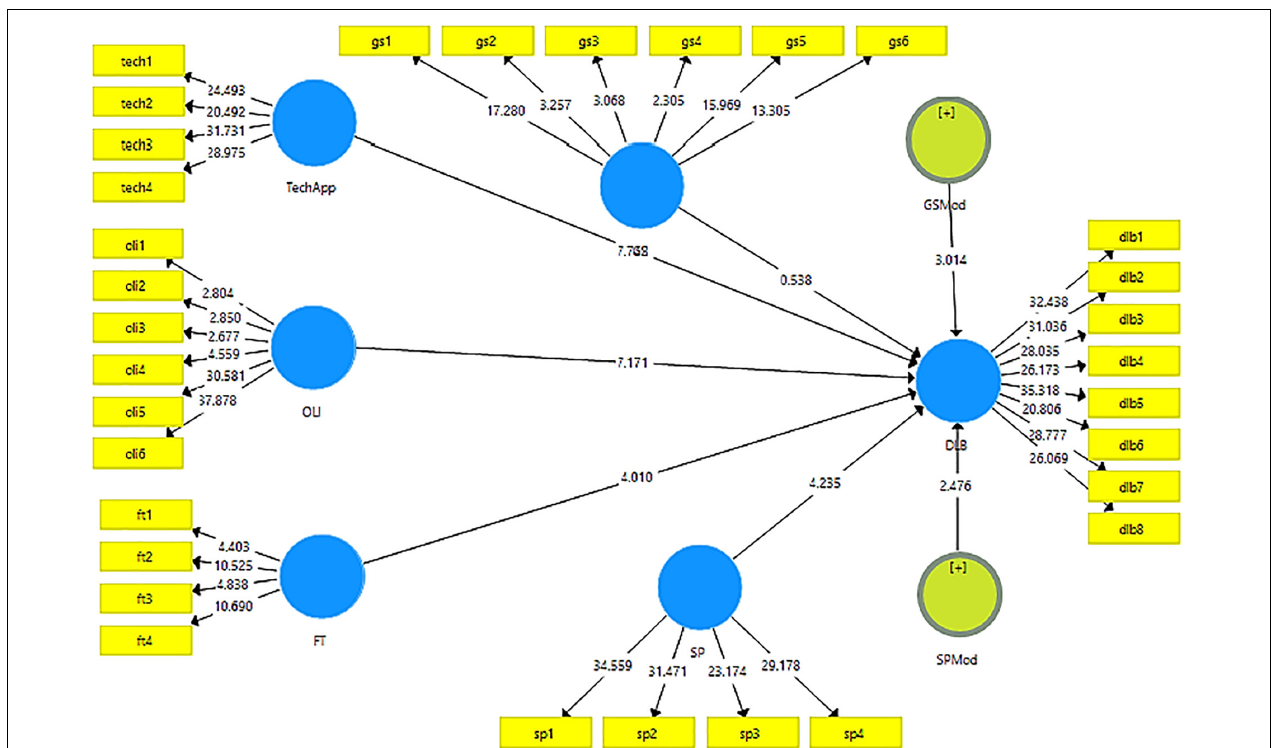
FIGURE 3 | Consistent